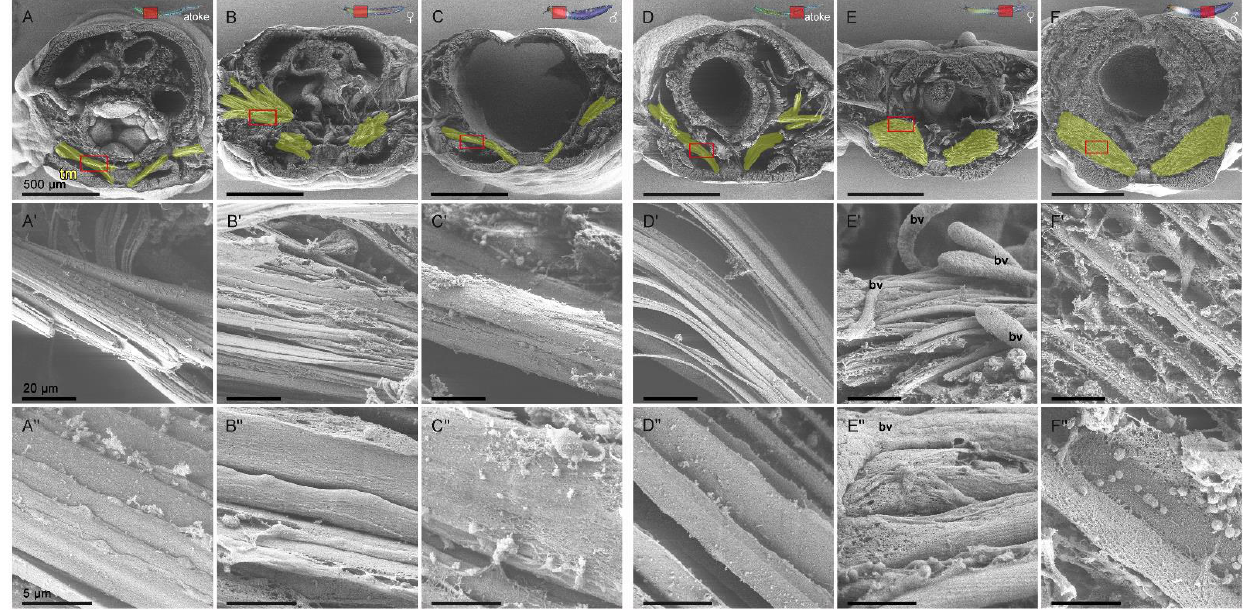
Figure 4. Sexual maturation similarly affects the ultrastructure of transversal muscles along the body axis in scanning electron microscopy (SEM). ( A – F ) Overview of the used cross-sections with transversal muscles (tm) marked in yellow and ( A’ – F” ) ultrastructure of the muscle surface, which were revealed by SEM of anterior and posterior cross-sections of the same worm. ( A – C ) While only minor modifications in the complete tm complex were found in the anterior segments, ( D – F ) there is an extreme remodeling in the form of strong inflation of the whole muscle complex in the posterior segments. ( A’ , A” – C’ , C” ) The surface of the anterior tm fibers appear fenestrated and covered with small holes, ( E’ , E” , F’ , F” ), which is more pronounced in the posterior segments. The tm show signs of cytolysis, i.e., surface dissolution and disintegration, which is also reflected in the release of large quantities of spherical structures covering the transversal fibers. In addition, an overall growth of blood vessels (bv) is detectable. Abbr.: bv blood vessel. Scale bars = A –F 500 µm, A’–F’ 20 µm and A”–F” 5 µm.